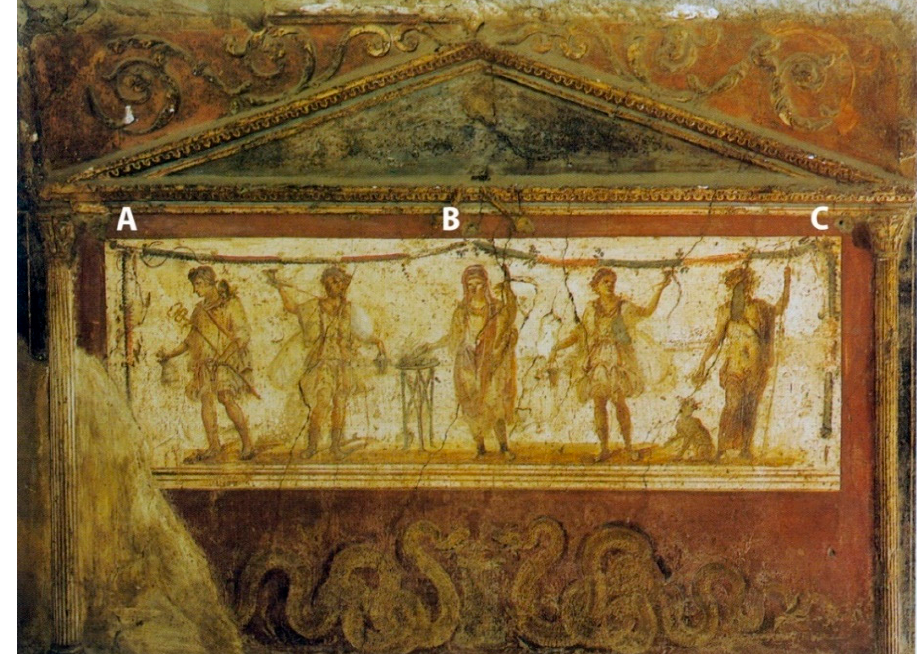
Figure 10. Caupona of Lucius Vetutius Placidus (1.8.8), Pompeii. Upper register includes a genius , flanked by two lares , with Mercury on the far left and Bacchus on the far right. Three holes to hang garlands indicated by letters ( A – C ). (Modified by author, after Fröhlich 1991, Taf. 2.1).